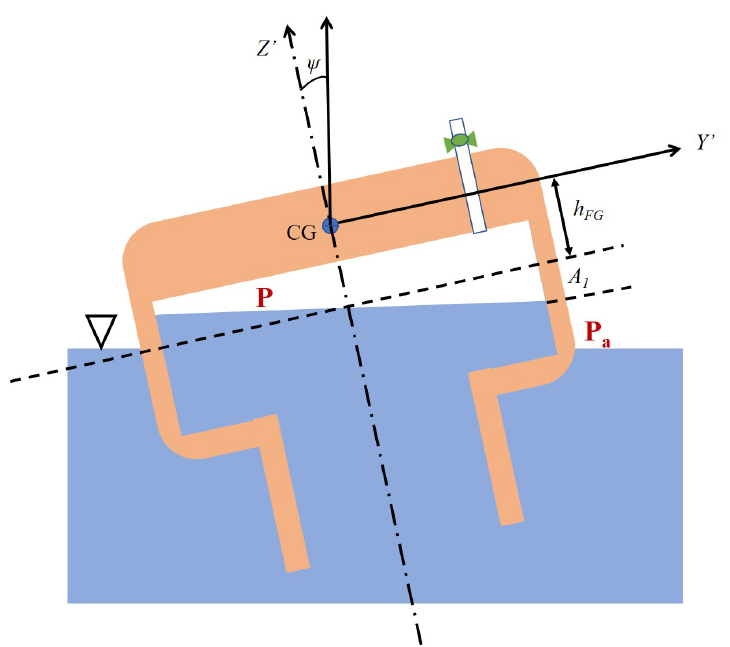
Figure 3. SSF Platform heeled by an angle θ